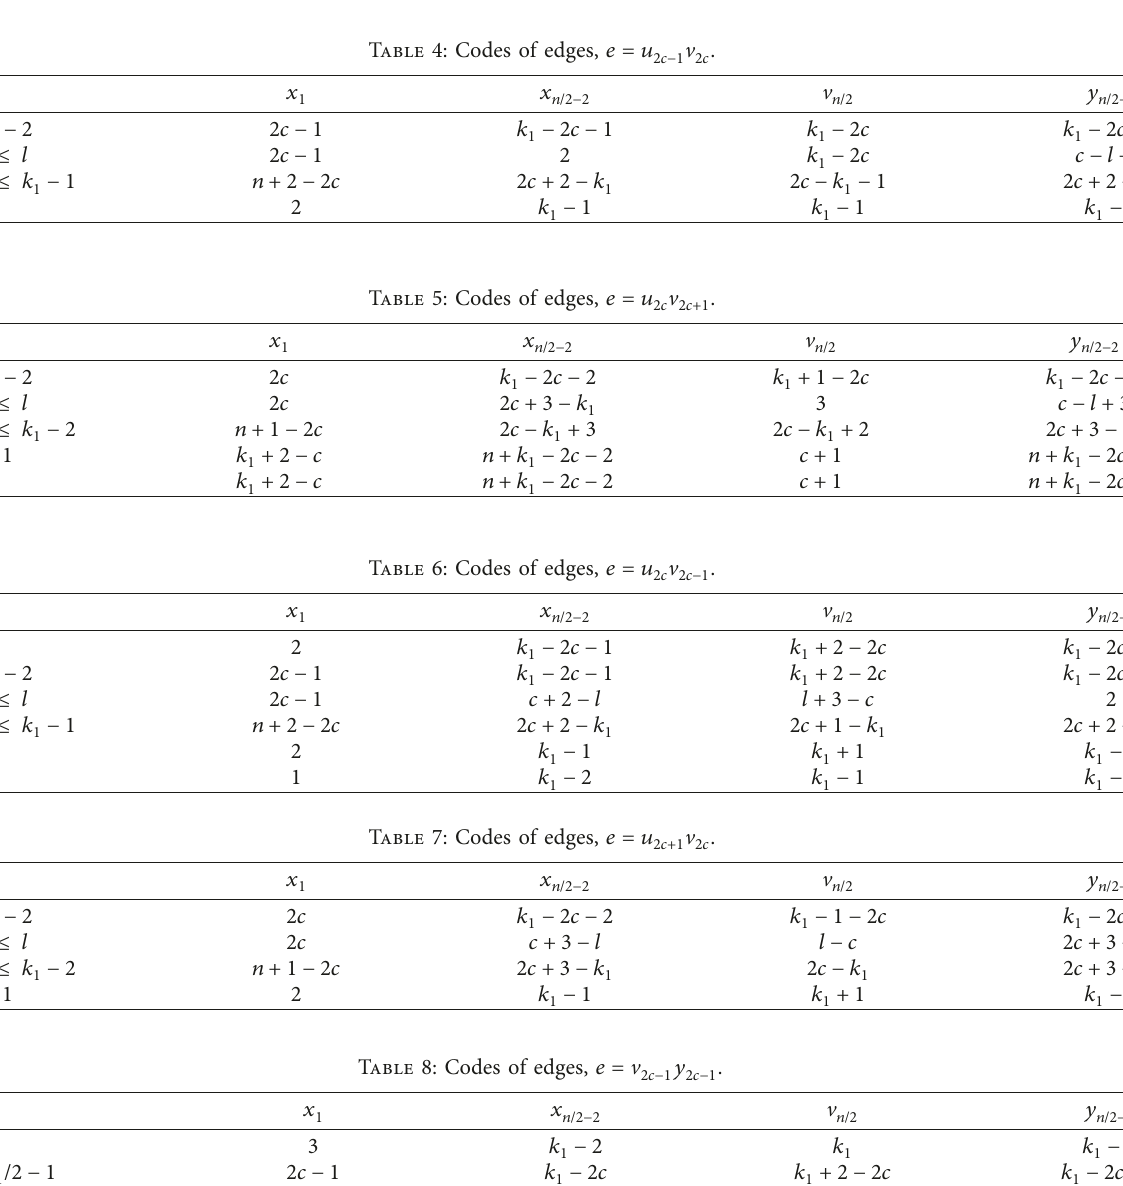
Table 4: Codes of edges, e � u